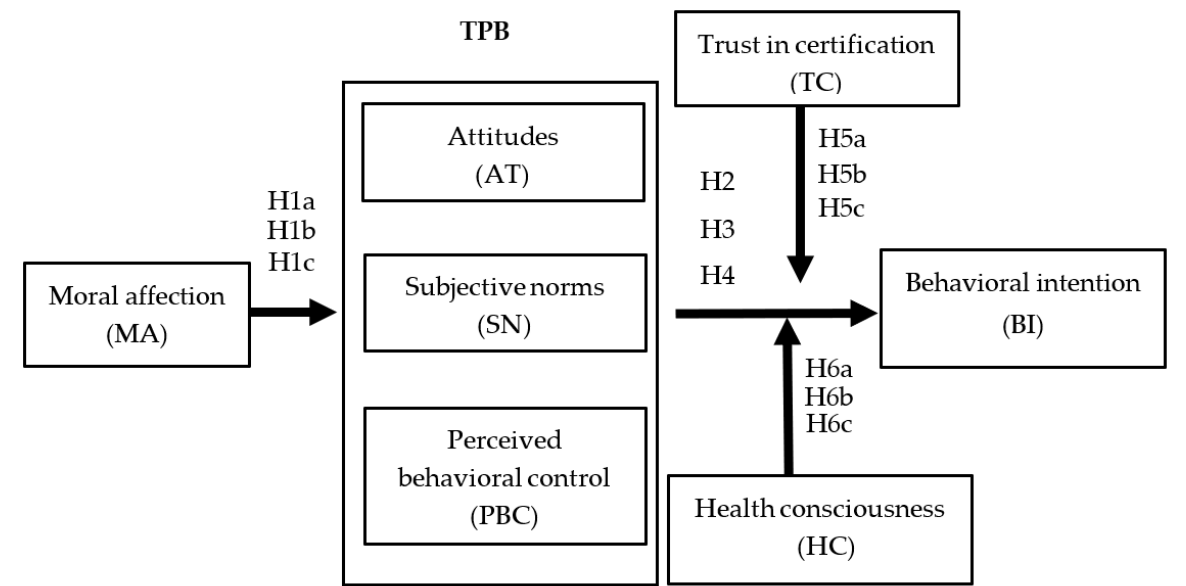
Figure 1. Conceptual framework and hypotheses of the study.